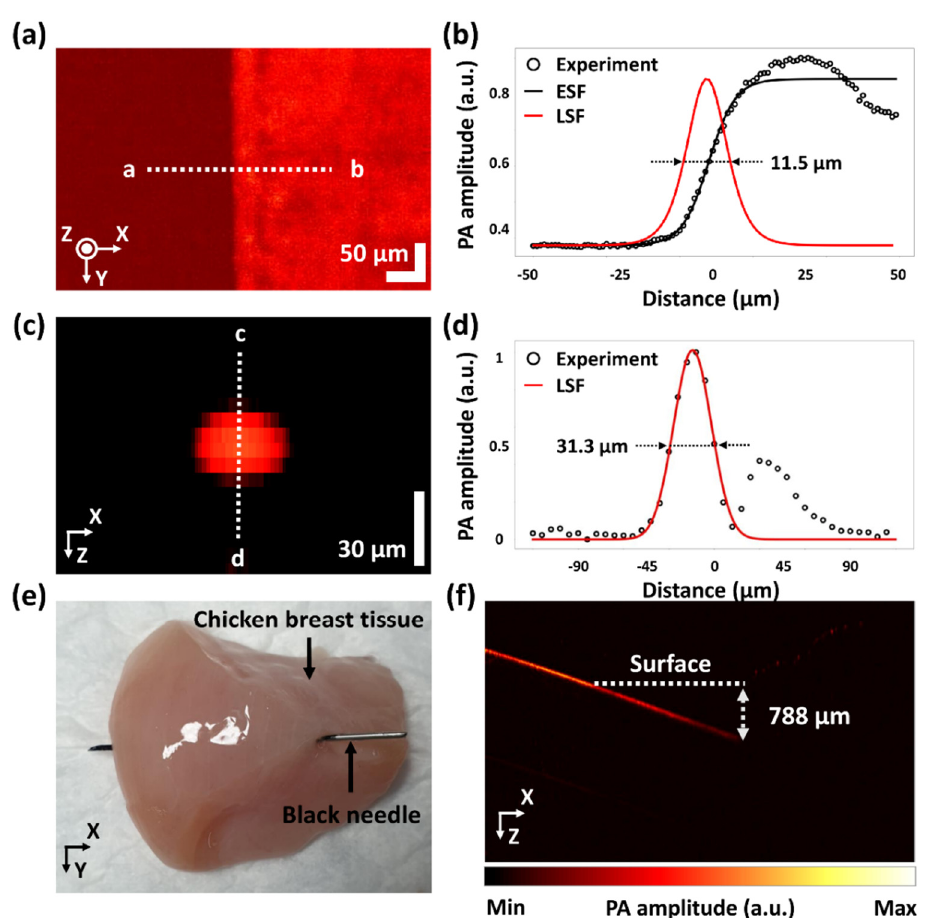
Figure 2. Quantitative evaluations of WP-GVS-HH-PAM performance. ( a ) PA MAP image of a sharp blade. ( b ) ESF and LSF fitting graph of the PA MAP data across the line a–b in ( a ). ( c ) PA B-scan image of a 7 µ m diameter carbon fiber. ( d ) LSF fitting graph with Gaussian profiling of the PA data across the line c − d in ( c ). ( e ) Photograph of the prepared chicken breast tissue inserted with the black need for measuring an imaging depth. ( f ) PA B-scan image for imaging depth measurement obtained with the prepared sample in ( e ). ESF, edge spread function; LSF, line spread function; MAP, maximum amplitude projection.